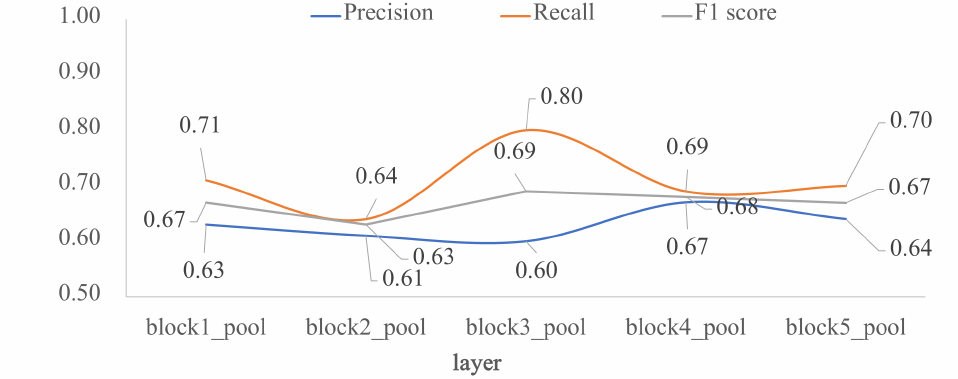
Figure 5. Impact of the depth for the custom architecture in terms of P , R and F1 score: external test. The x -axis corresponds to the last layer before the FC1 layer, and the y -axis are the evaluated metrics.